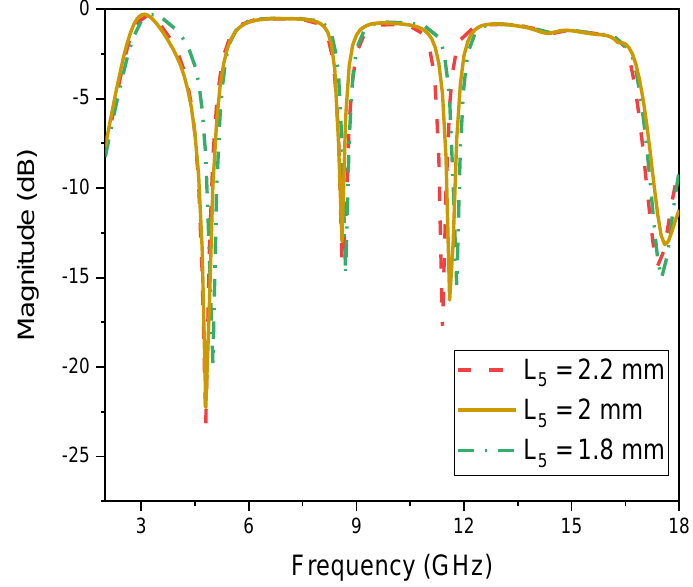
Figure 15. Validation of third band control w.r.t L 5.